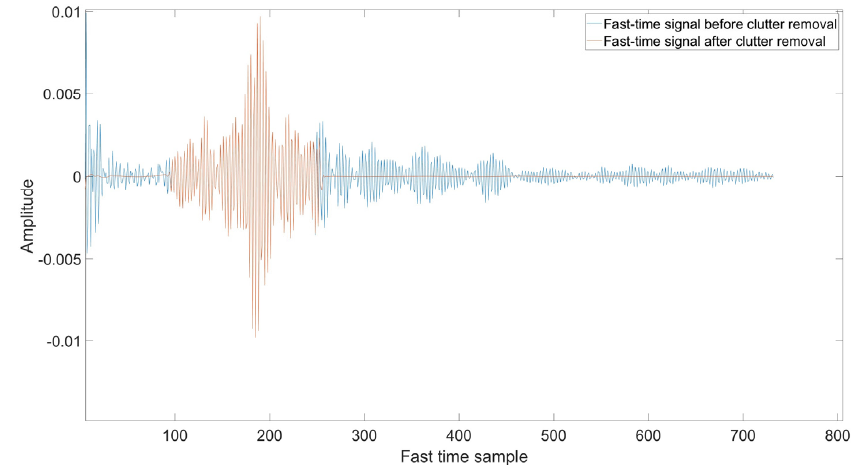
Figure 6. Clutter removal signal.